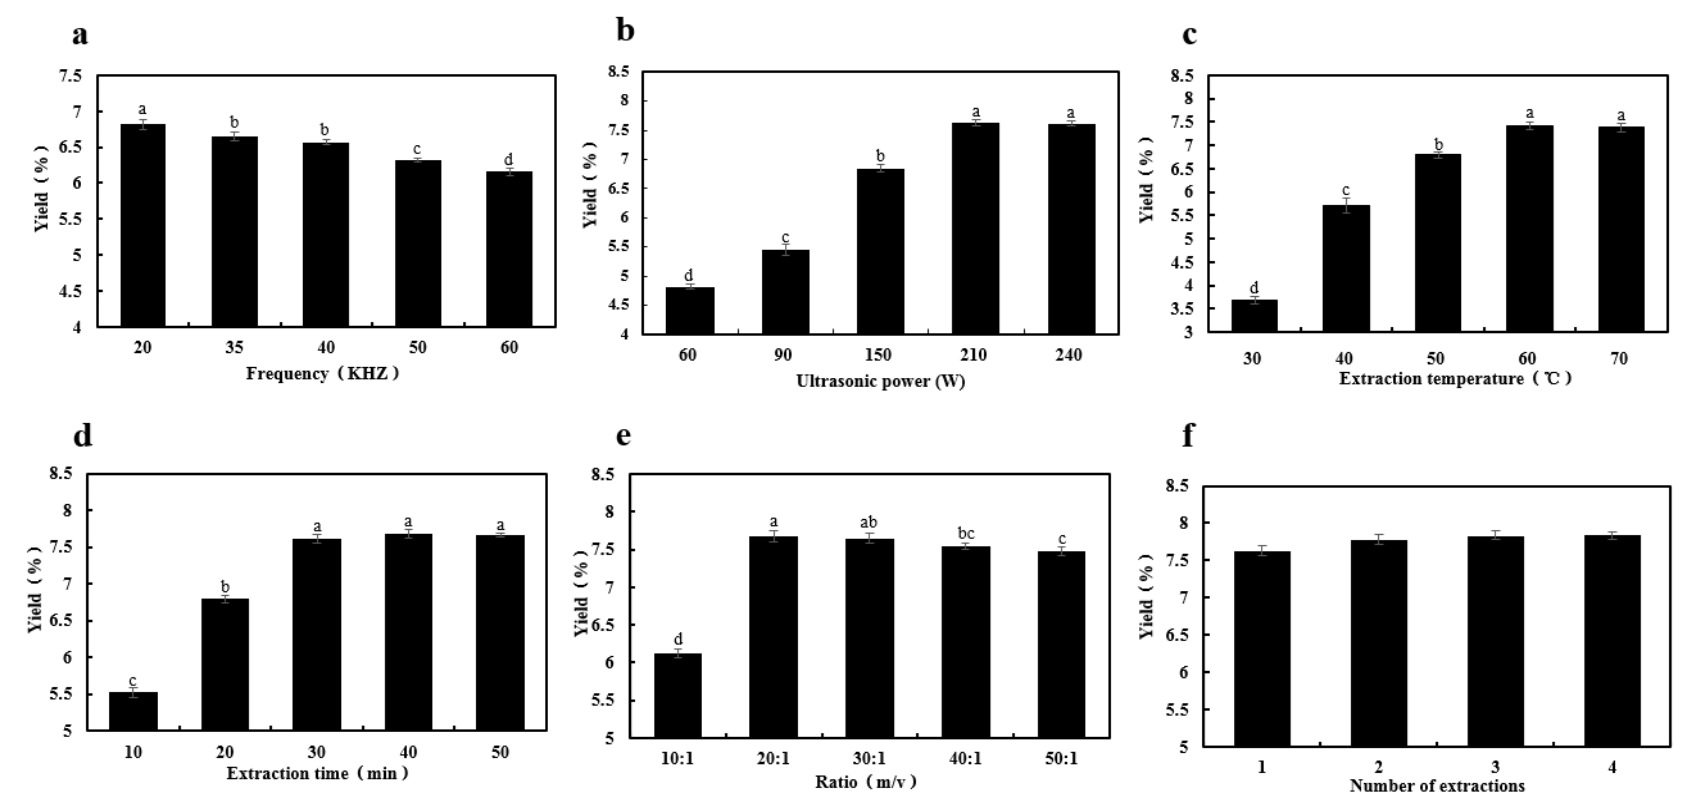
Figure 1. Effect of ultrasound frequency ( a ), ultrasound power ( b ), extraction temperature ( c ), extraction time ( d ), ratio of liquid to raw material ( e ) and number of extractions ( f ) on the yield of UAP ‐ VVP ( a – d represent the significant differences between various experiments for p < 0.05).